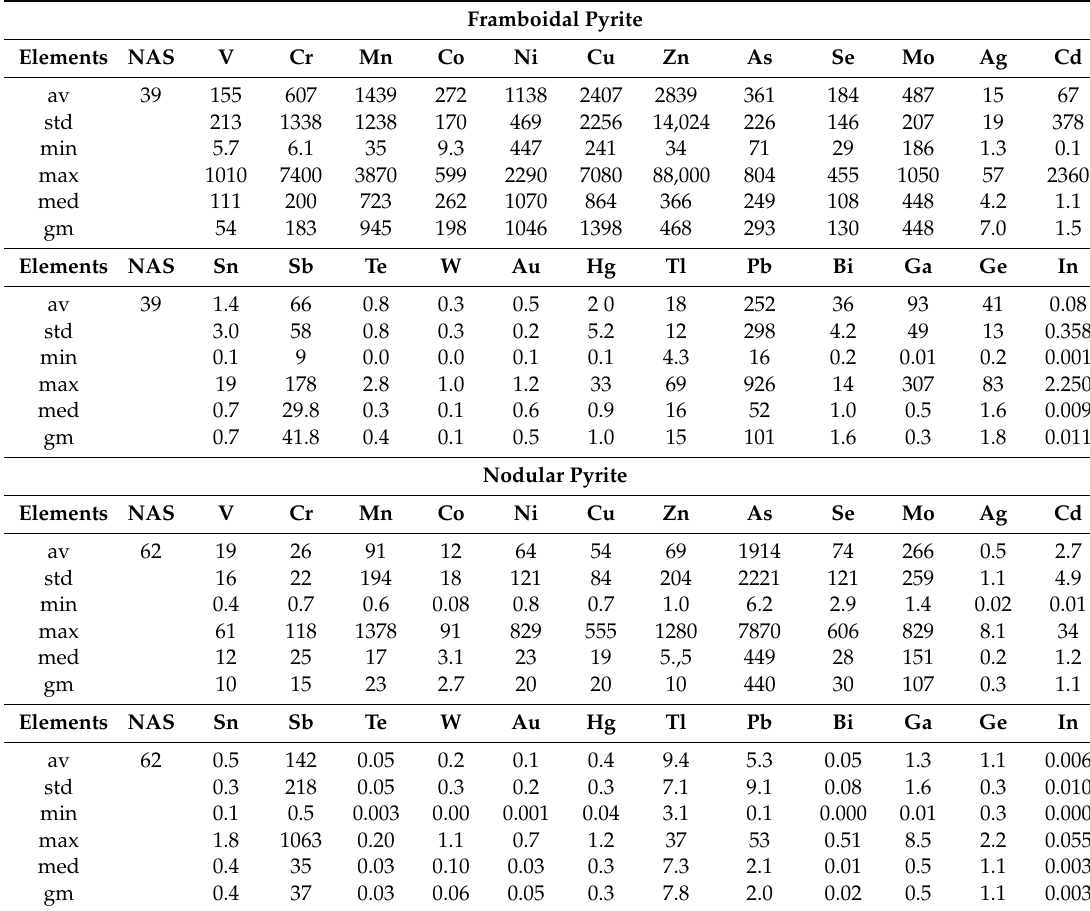
Table 2. Trace elements in framboidal pyrite from carbonaceous shales of the Bazhenov Formation, ppm. Framboidal